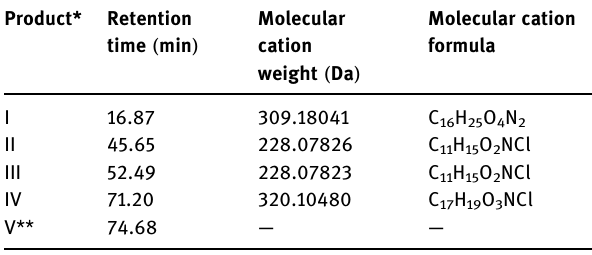
Table 1: LC - MS detection